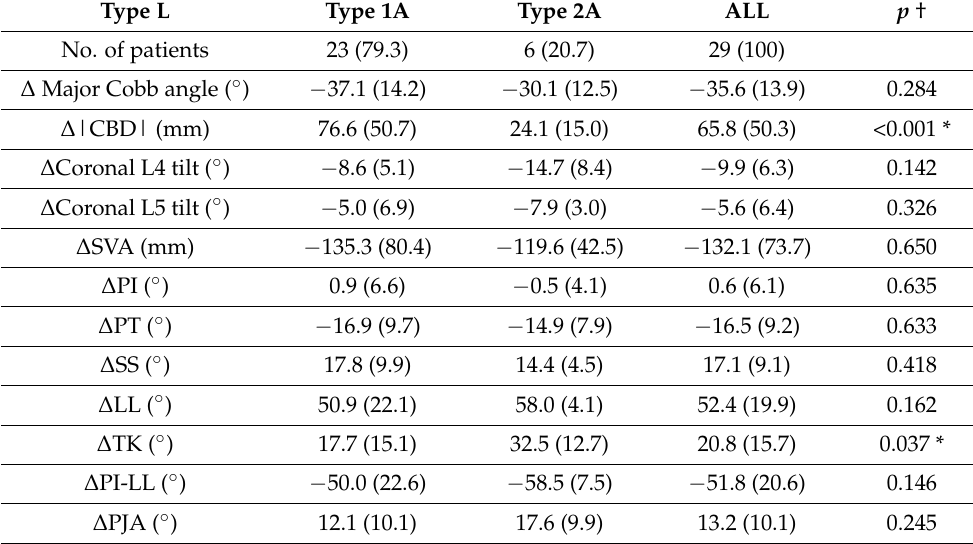
Table 4. Parameter changes of patients in the two groups at last follow-up. Data presented as mean (SD) or number of patients (%). CBD, coronal balance distance, SVA, sagittal vertical axis; TK, thoracic kyphosis; LL, lumbar lordosis; PI, pelvic incidence; PT, pelvic tilt; SS, sacral slope; PJA, proximal junctional angle. † Comparison between groups. * p < 0.05 statistically